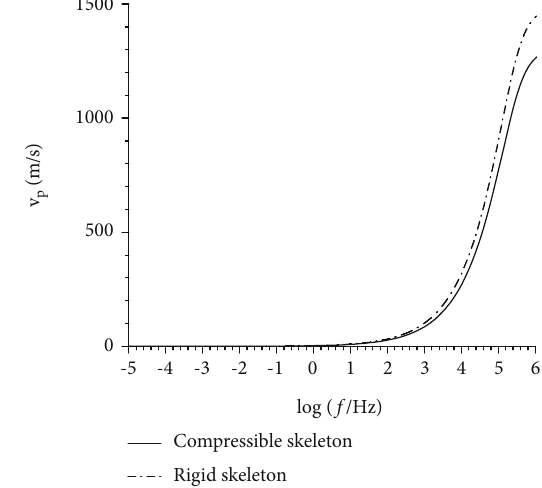
Figure 3: Ampli fi cation of Figure 2 at frequencies 10 -5 to 1 Hz.